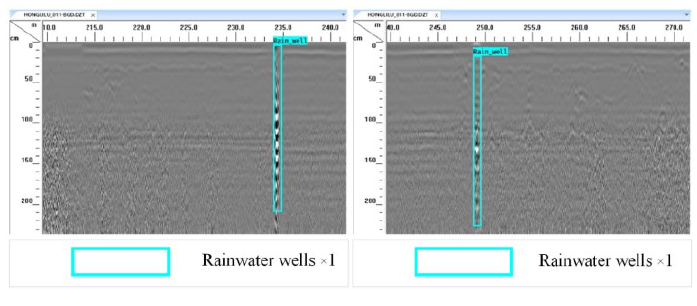
(a) Recognition results of rainwater